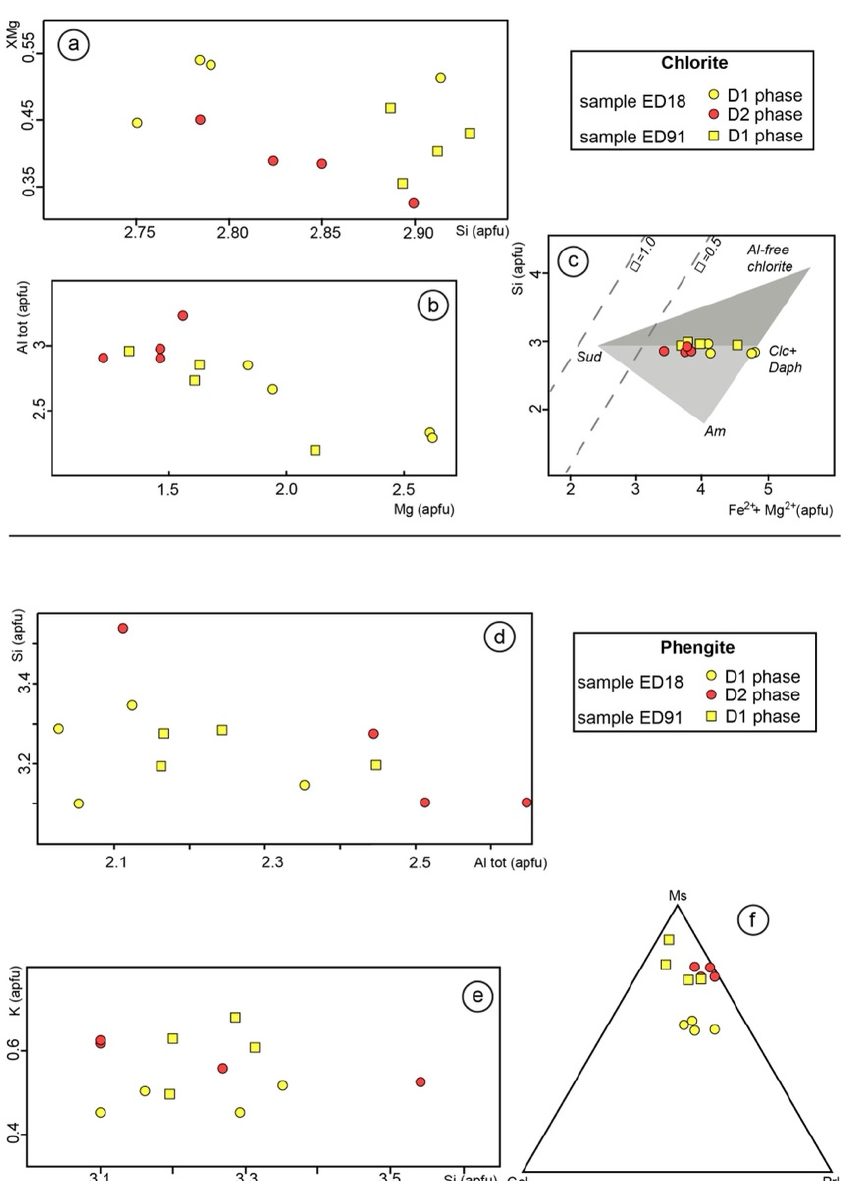
Figure 9. Geochemistry of chlorite ( a – c ) and phengite ( d – f ) selected on the X-ray calibrated maps of the samples ED18 and ED91 with XMapTools software [98]. Chlorite and phengite structural formulas are calculated assuming 14 and 11 oxygen, respectively. The chlorite grains (Chl 1 ) grown along the S1 foliation show XMg values ranging between 0.35 and 0.47, while the Si- content ranges from 2.89 and 2.93 a.p.f.u. (Figure 9a, Table S1 on S3 supplementary material). The Al- and Mg- contents range between 2.43 and 2.96 a.p.f.u. and between 1.33 and 2.12 a.p.f.u., respectively (Figure 9b). The composition